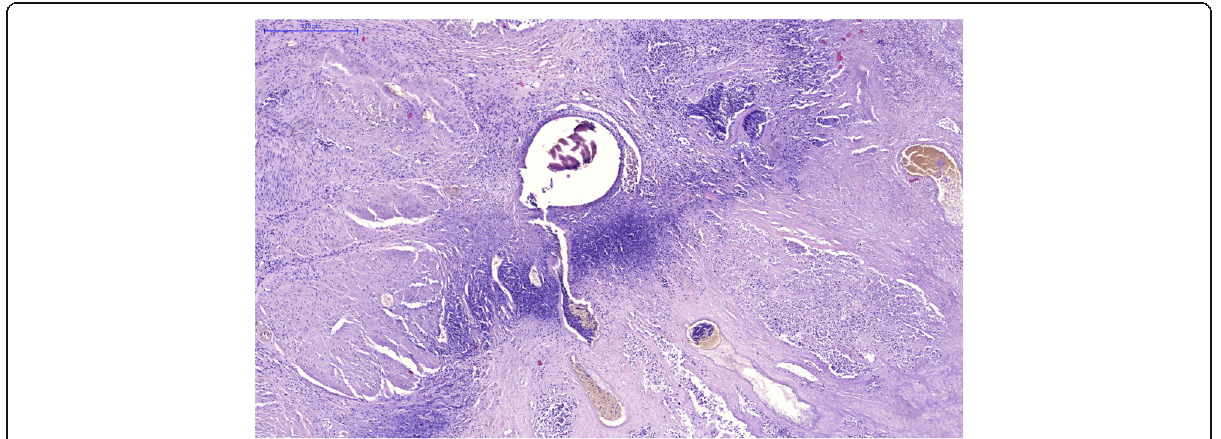
Fig. 6 Microscopic view (normal muscle tissue, demarcation zone, tumor tissue and microembolus in